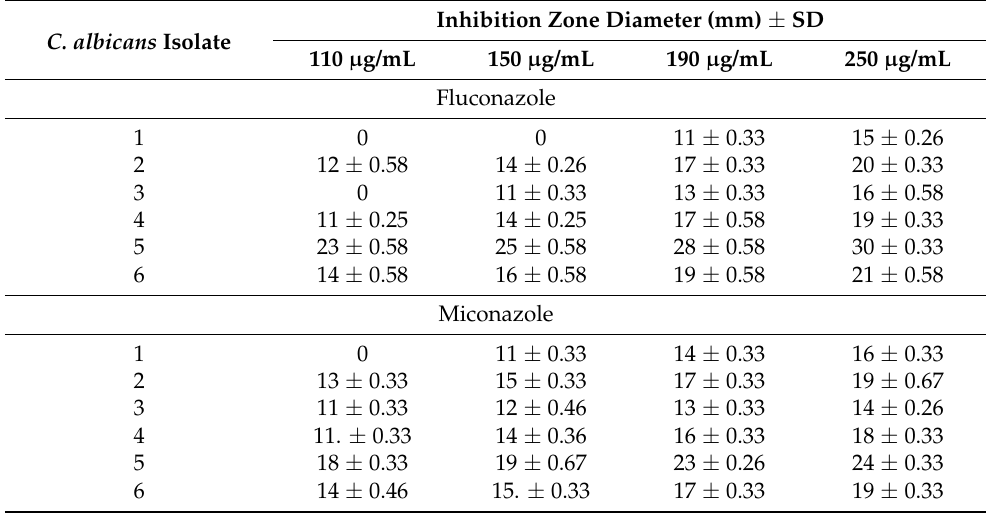
Figure 2. Linear relationship between different concentrations of the purified extract (µg/mL) and the inhibition zone diameter (mm). Table 2. In vitro susceptibilities of six C. albicans isolates to fluconazole, miconazole, Lamisil, and the antifungal metabolite determined by agar well diffusion